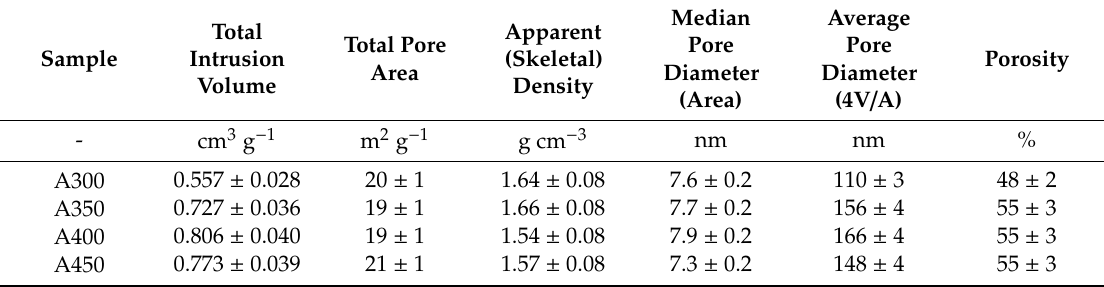
Table 2. Porous texture data from mercury porosimetry (N =